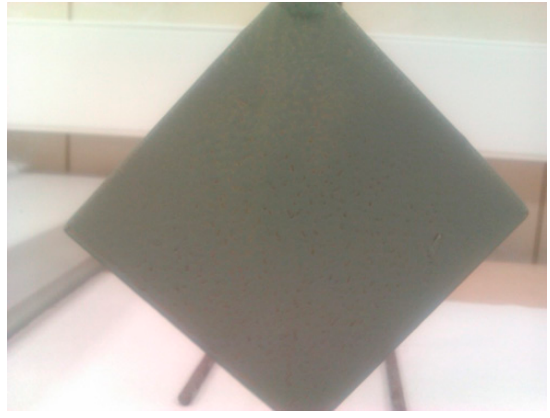
Figure 5. Evaluation of SiC-based slurry adhesion to a copper plate. Table 4. Bending properties of the tested multilayer beams with SiC.